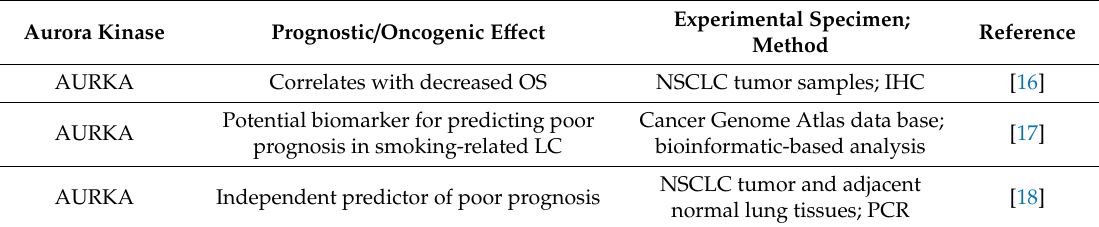
Table 1. E ff ects of overexpression of AURKA and / or AURKB in lung cancer. Experimental Aurora Kinase Prognostic / Oncogenic E ff ect